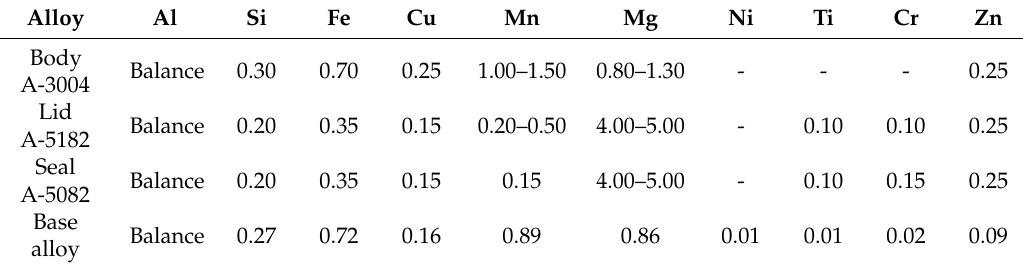
Table 2. Chemical compositions of the alloys contained in the aluminium cans and the final composition of the fused alloy (base alloy) in wt.%.